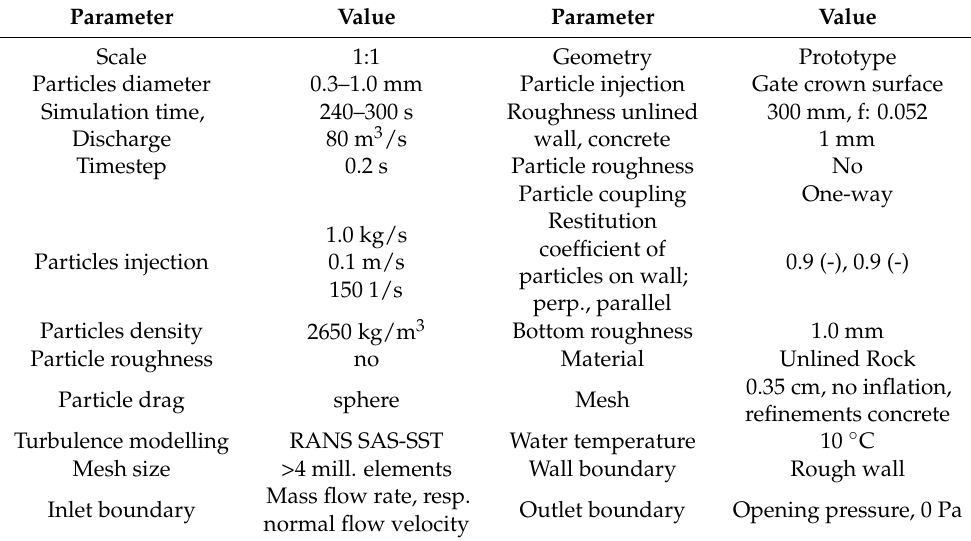
Table 2. Characteristic parameters for 3D CFD with particle tracking